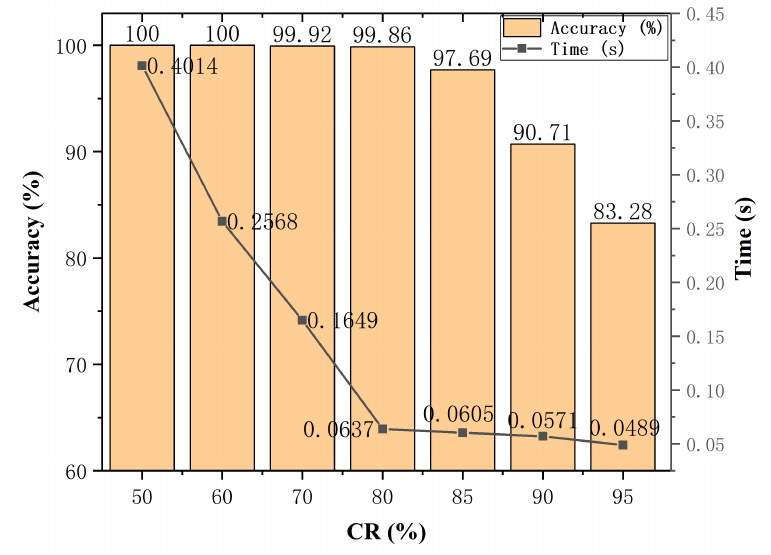
Figure 10. Diagnosis accuracy and time under different compressed